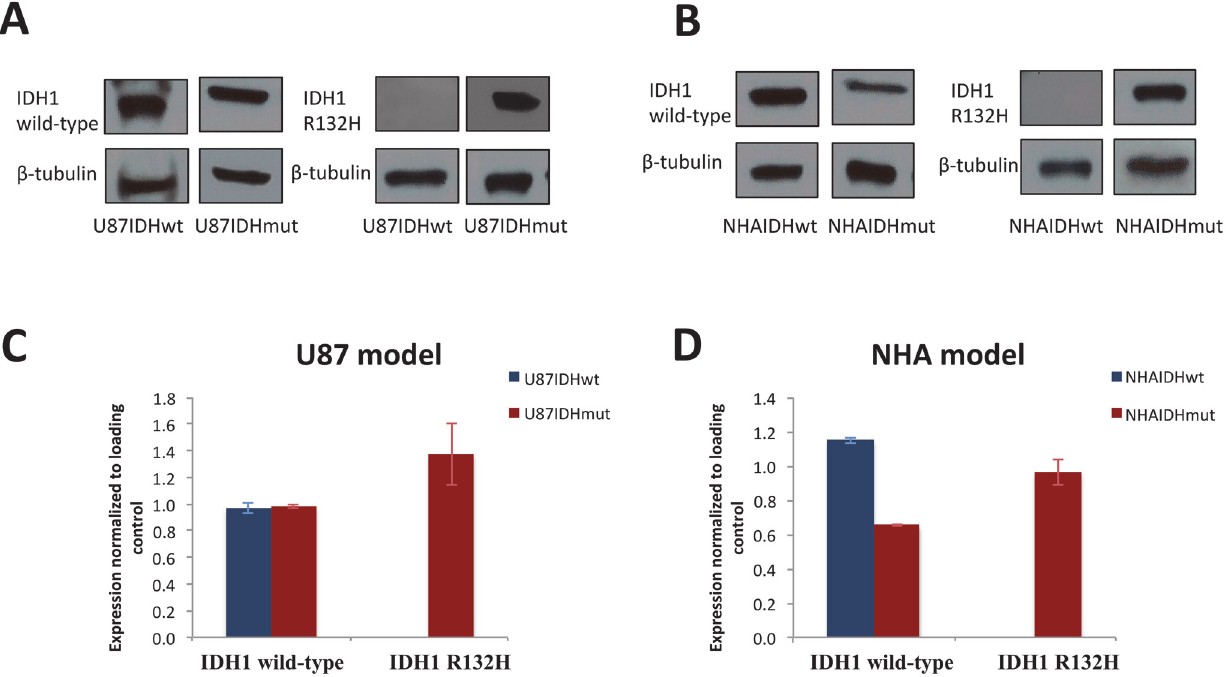
Fig 1. Western blots indicate that IDH1 protein expression is comparable between IDHwt and IDHmut cells. U87IDHwt and U87IDHmut cells (A) and NHAIDHwt and NHAIDHmut cells (B) were analyzed for expression of the IDH1 wild-type and R132H mutant proteins. β -tubulin was used as the loading control. Quantification of the results from 3 independent experiments for U87 (C) and NHA (D) models are